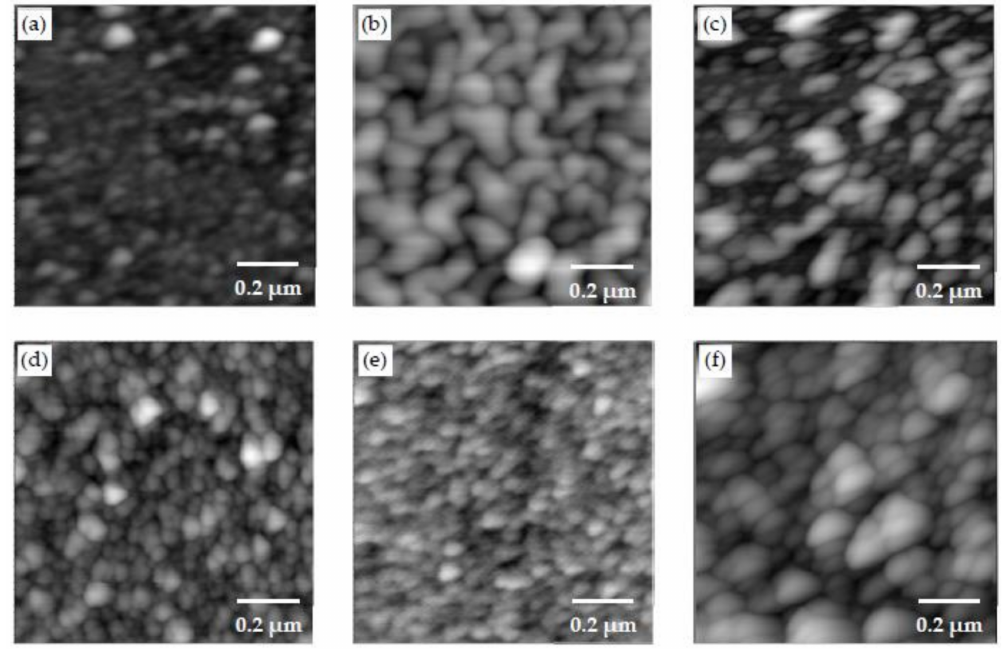
Figure 5. AFM scans of the ( a ) PEI/PSS; ( b ) PDDA/PAA; ( c ) PEI/PAA; ( d ) PEI/PSS-CSH; ( e ) PDDA/PAA-CSH and ( f ) PEI/PAA-CSH samples made of three bilayers. Table 2. Roughness value of the samples made with only polymers and polymer complexes. Sample